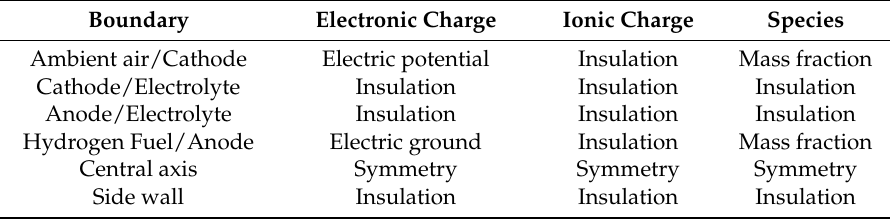
Table 3. Boundary